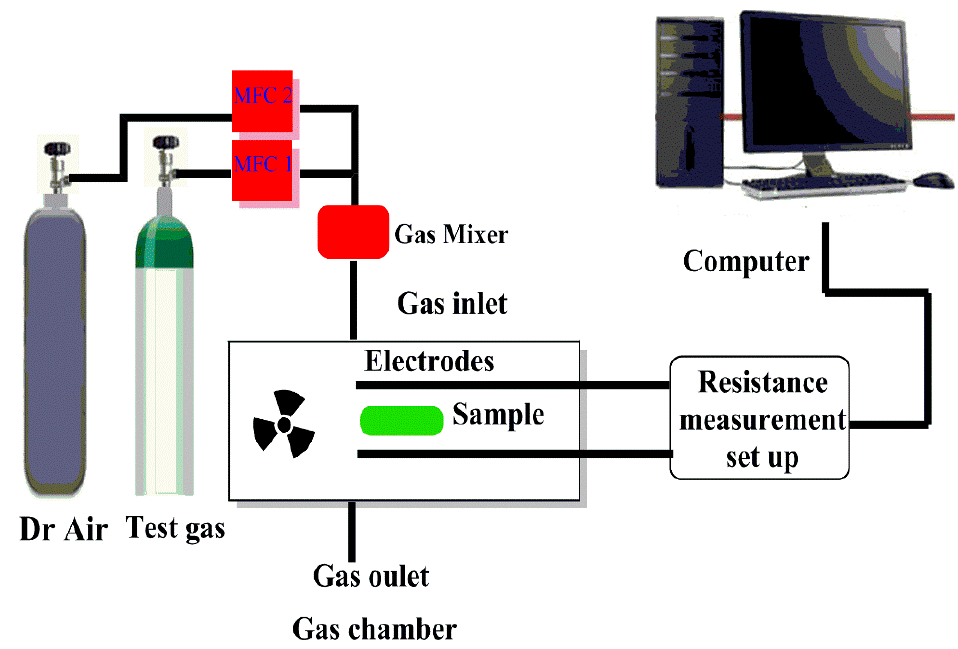
Figure 2. The gas sensing setup diagram.